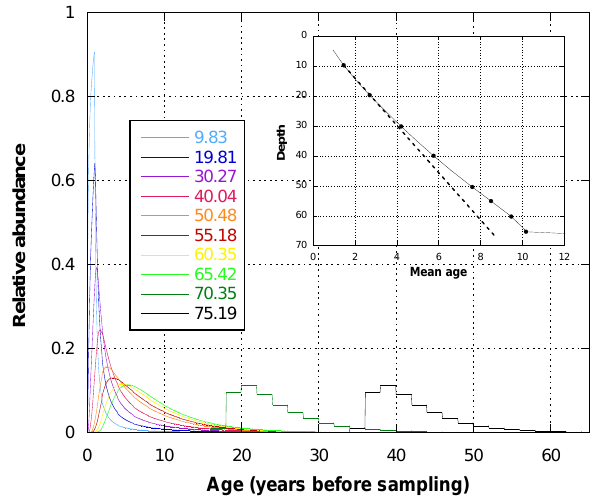
Fig. 8. Normalized age distributions for CO 2 in firn air at selected depths (given in the legend) from the moving-coordinate firn model (see text). The step-like structure within the lockin zone is a result of model discretization and does not reflect any underlying physics. The inset shows the mean age as a function of depth, with points indicating the means for the particular distributions selected for the main plot. The dashed line is included only to highlight the depar- ture from